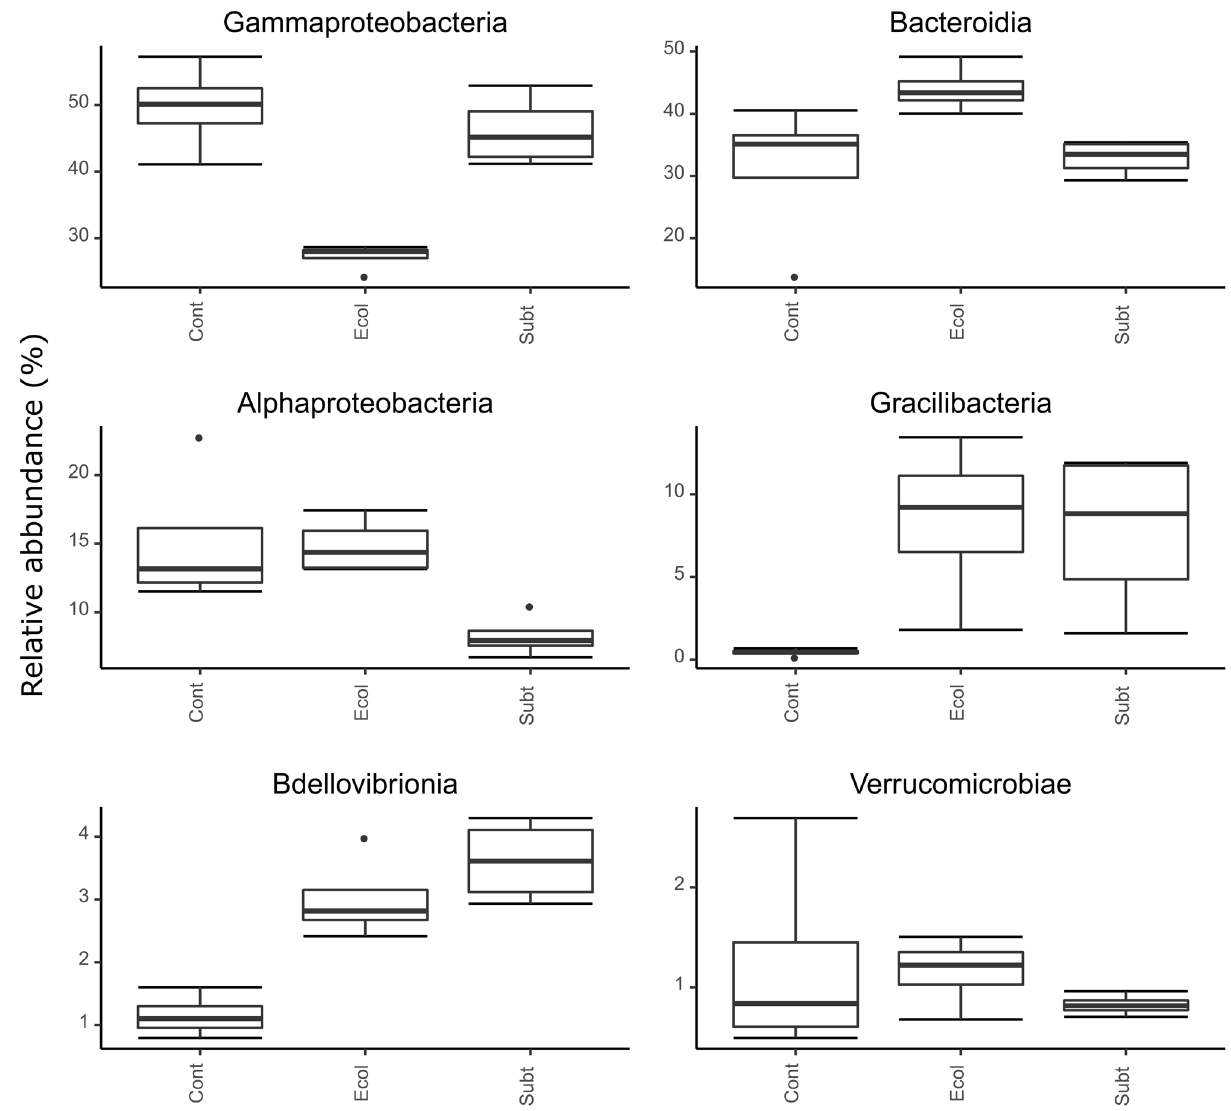
Figure 4. Relative abundances of the six most abundant prokaryotic classes. Results of GLM- ANOVA analyses Gammaproteobacteria: F 2,9 = 5.91, P = 0.023; Bacteroidia: F 2,9 = 8.84, P = 0.008; Alphaproteobacteria: F 2,9 = 1.1, P = 0.375; Gracilibacteria: F 2,9 = 17.21, P < 0.001; Bdellovibrionia: F 2,9 = 52.29, P < 0.001; Verrucomicrobiae: F 2,9 = 0.05, P = 0.949. The groups sampled were: Cont: Control; Ecol: E. coli DH5α ; Subt: P. rubra